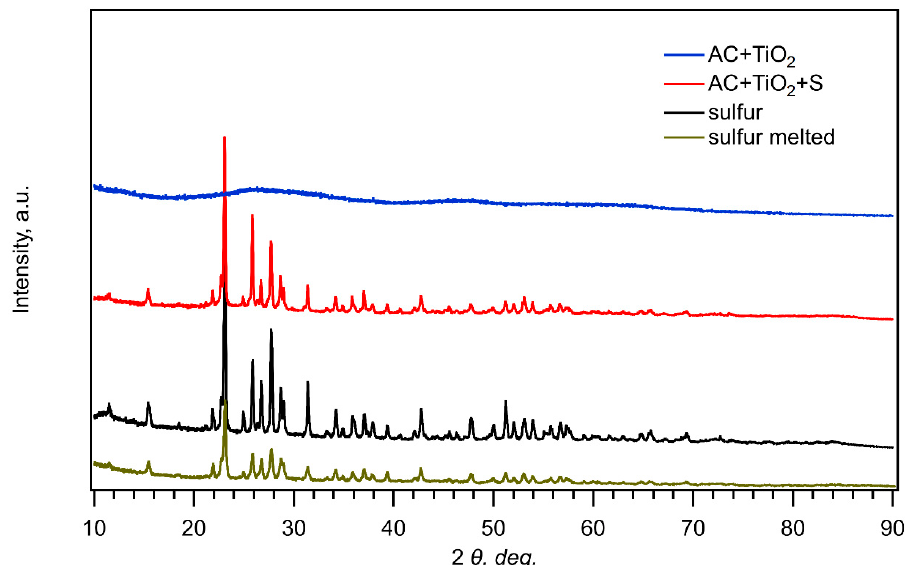
Figure 1. X-ray diffractograms of pure sulfur, melted sulfur, its composite with AC + TiO 2 , and pure AC + TiO 2 .